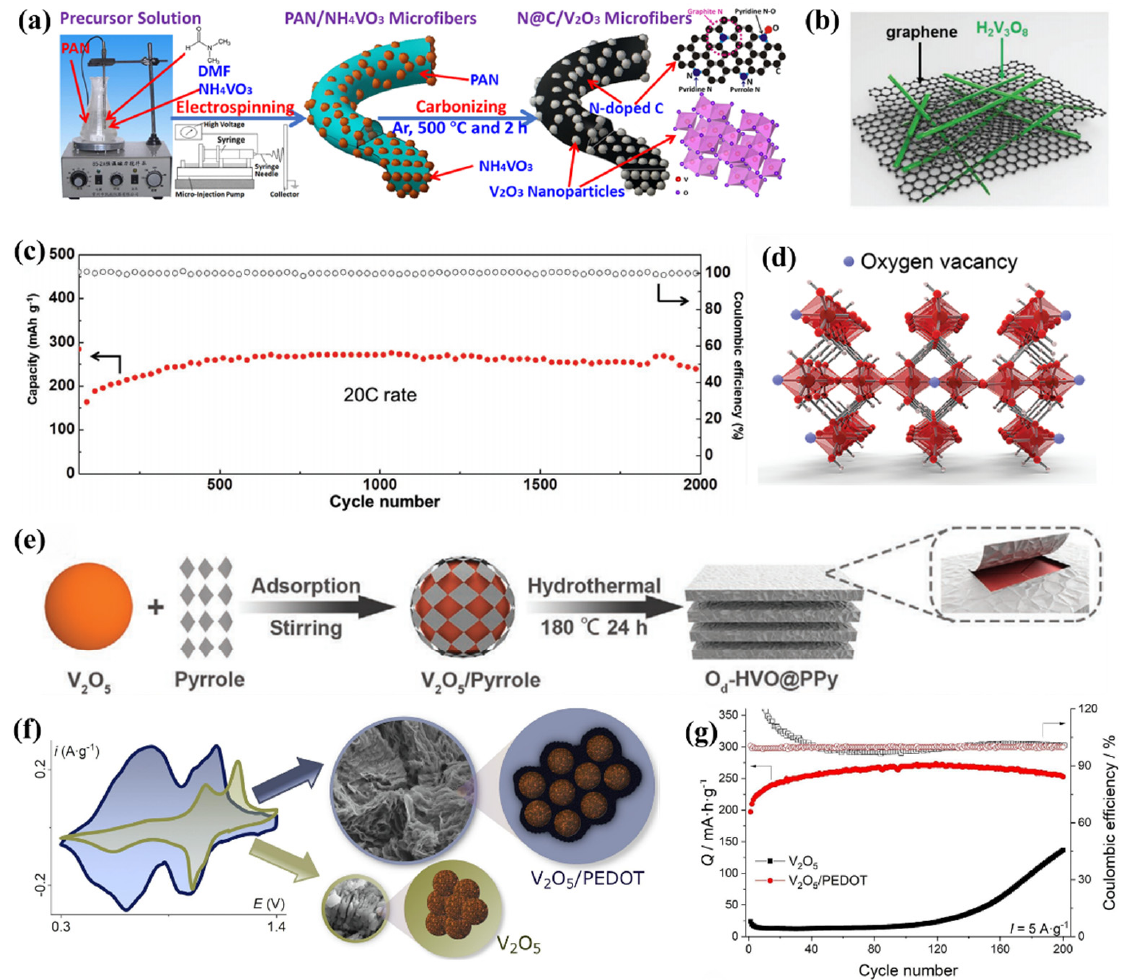
Figure 7. ( a ) Synthesis and structure of N@C/V 2 O 3 composites (Ref. [73]). ( b ) Structural sketch of H 2 V 3 O 8 NW/graphene composite material (Ref. [74]). ( c ) Long cycle stability of H 2 V 3 O 8 NW/graphene composite material at 20 C rate (Ref. [74]). ( d ) Crystal structure diagram of O d − VO 2 ·xH 2 O (Ref. [75]). ( e ) Schematic diagram of preparation process of O d –HVO@PPy nanosheets (Ref. [75]). ( f ) Diagram of V 2 O 5 and V 2 O 5 /PEDOT [76]. ( g ) Cycle performance of V 2 O 5 and V 2 O 5 /PEDOT (Ref. [76]).